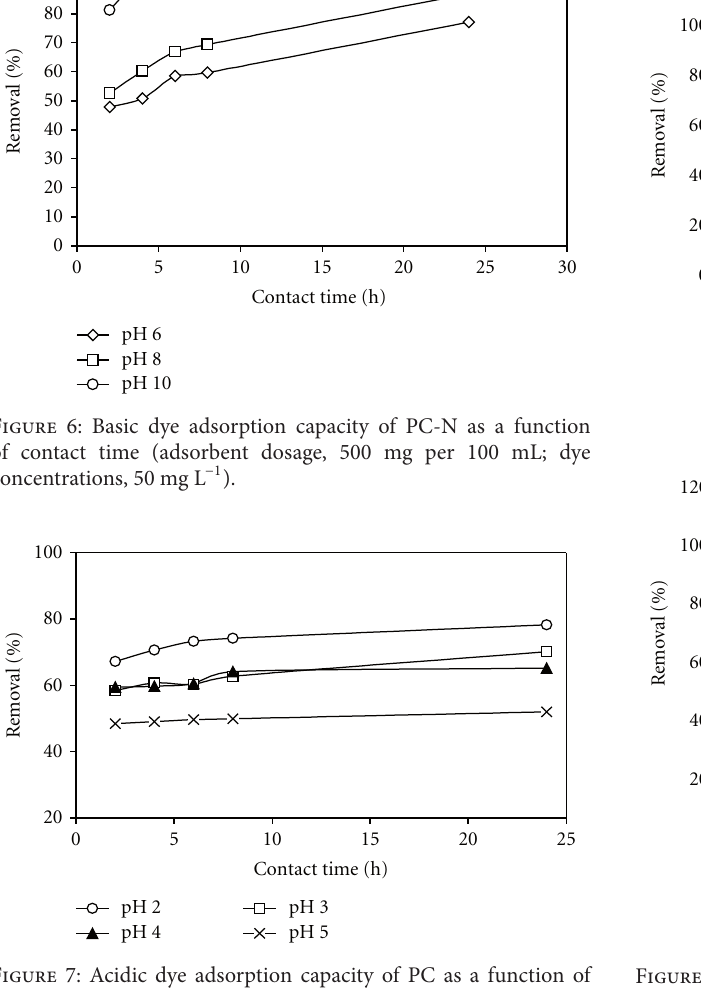
F 9: Cr (VI) adsorption capacity of PC (a) and OC (b) as a function of pH (Adsorbent dosage, 2500 mg per 100 mL; Cr (VI) concentration, 10 mg L